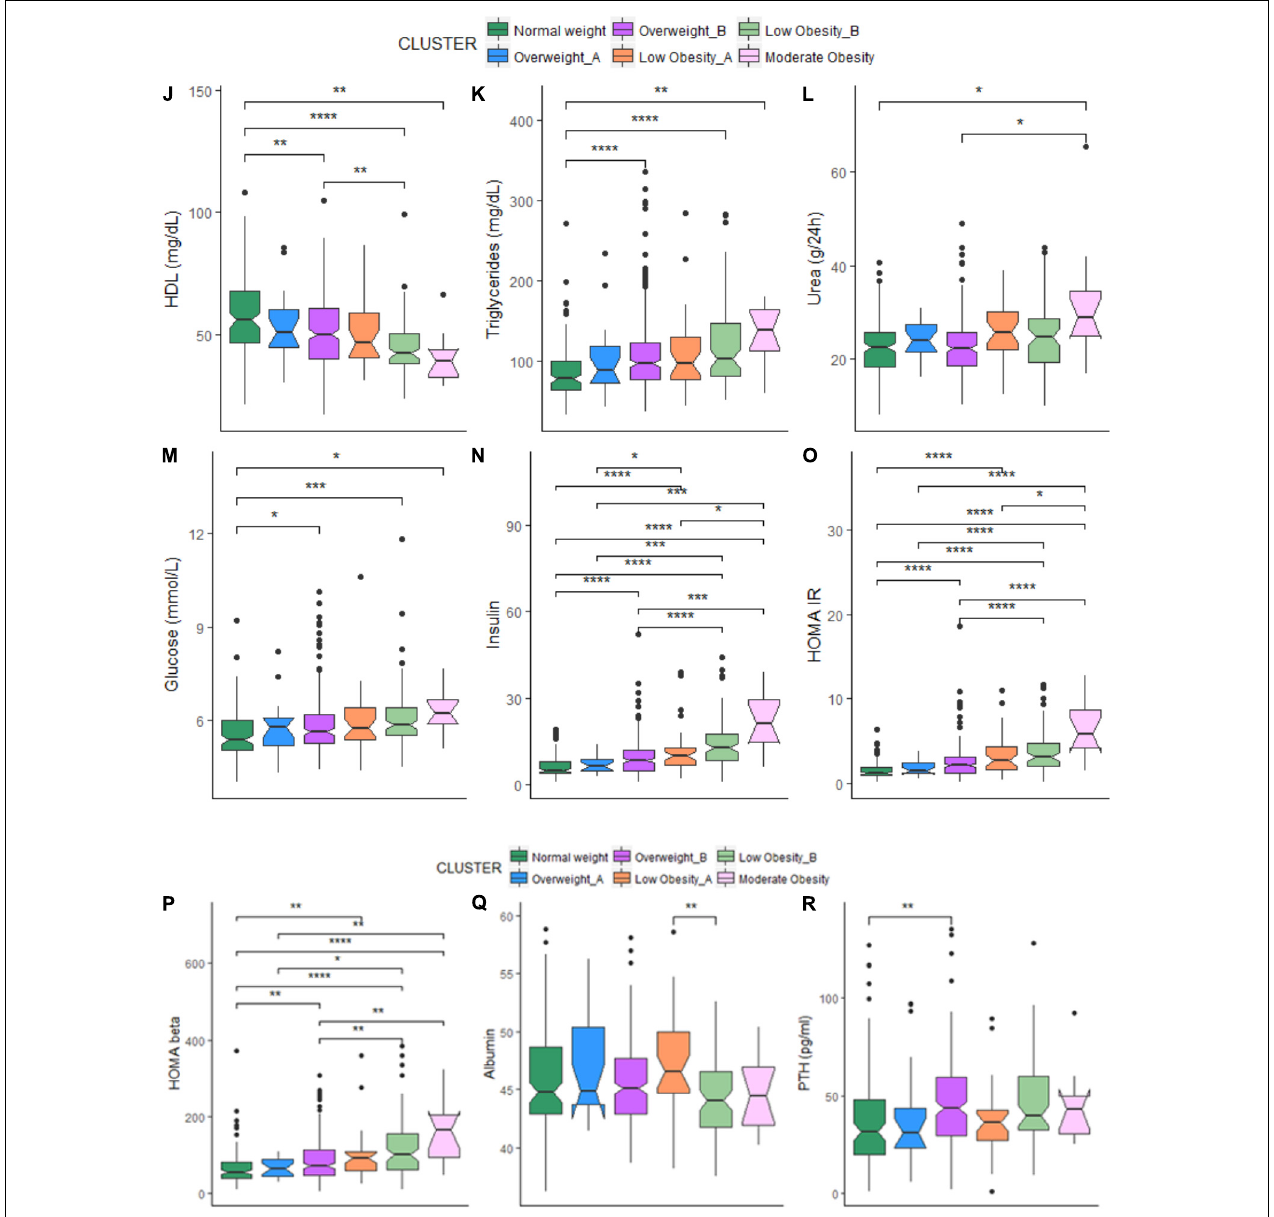
FIGURE 1 | (A–I) Box-plots and significant differences of metabolic parameters among clusters in women. Statistical analysis was perfomed by Kruskal–Wallis test ( p -values: ∗ p < 0.05, ∗∗ p < 0.01, ∗∗∗ p < 0.001, ∗∗∗∗ p < 0.0001). (J–R) Box-plots and significant differences of metabolic parameters among clusters in